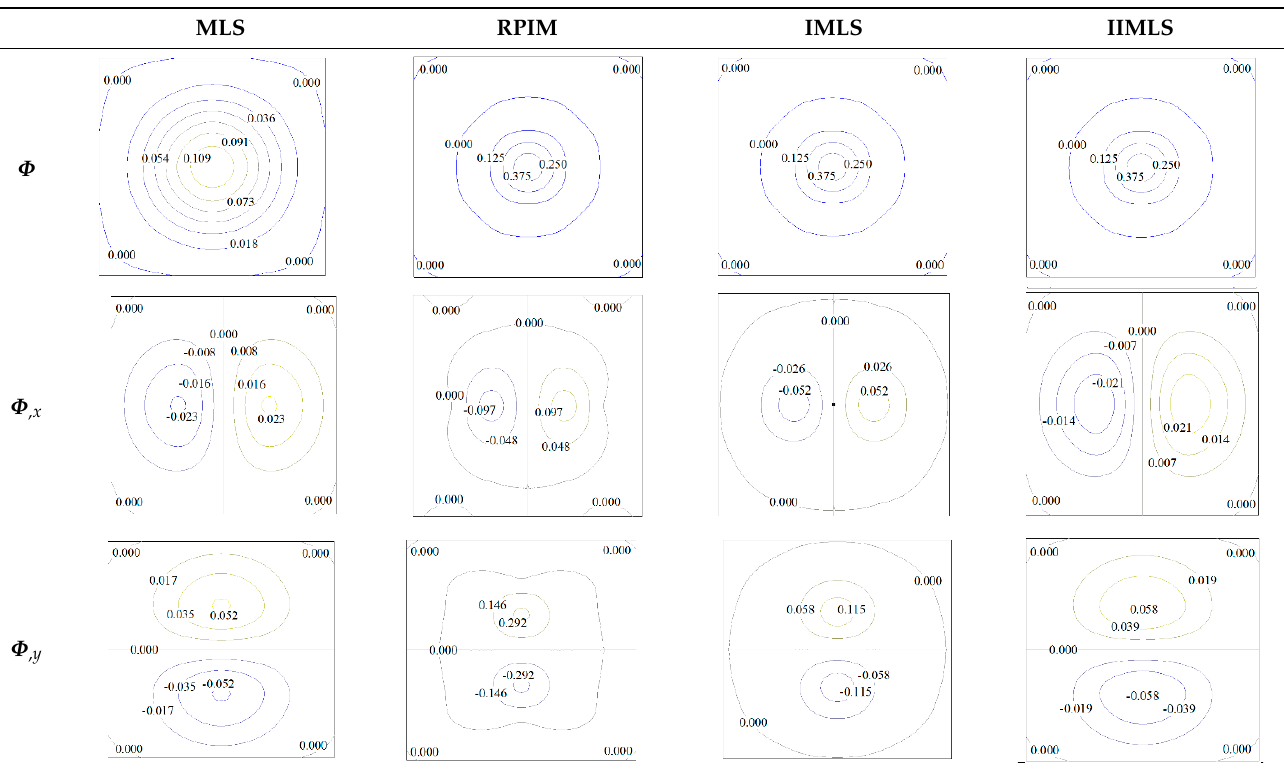
Figure 2. Deflection u 2 and its relative error at x 2 = 0 m. Figure 3 shows the numerical stress results of 22 σ on the central axis x 2 = 0 of the beam and the relative errors. The EFGM with relative errors below 0.38% showed the best numerical accuracy over all the four meshless schemes for this example. For the RPIM, the accuracy near the two fixed ends with a maximum relative error of 3.73%, which is higher than the relative error of 1.32% at the middle span of the beam, is relatively poor. The maximum relative errors of the IEGM and the IIEFGM are 3.51% and 4.27%, respectively. Figure 4 shows the cloud diagram of the Von Mises stress on the problem domain for the analytical solution and the four meshless numerical results. The numerical solutions of the Von Mises stress obtained by the four meshless methods showed good agreement to the exact ones.